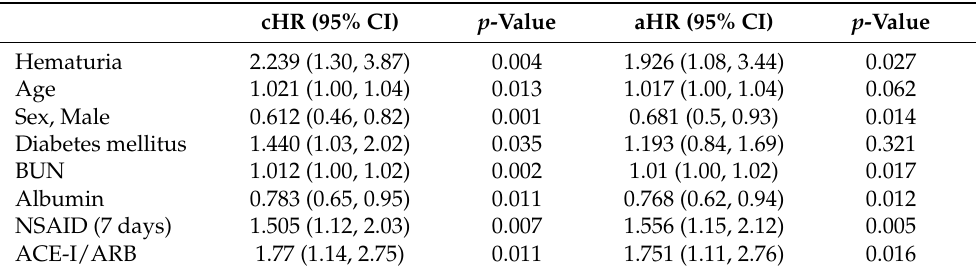
Table 2. Effects of hematuria on renal composite outcomes during a five-year follow-up.